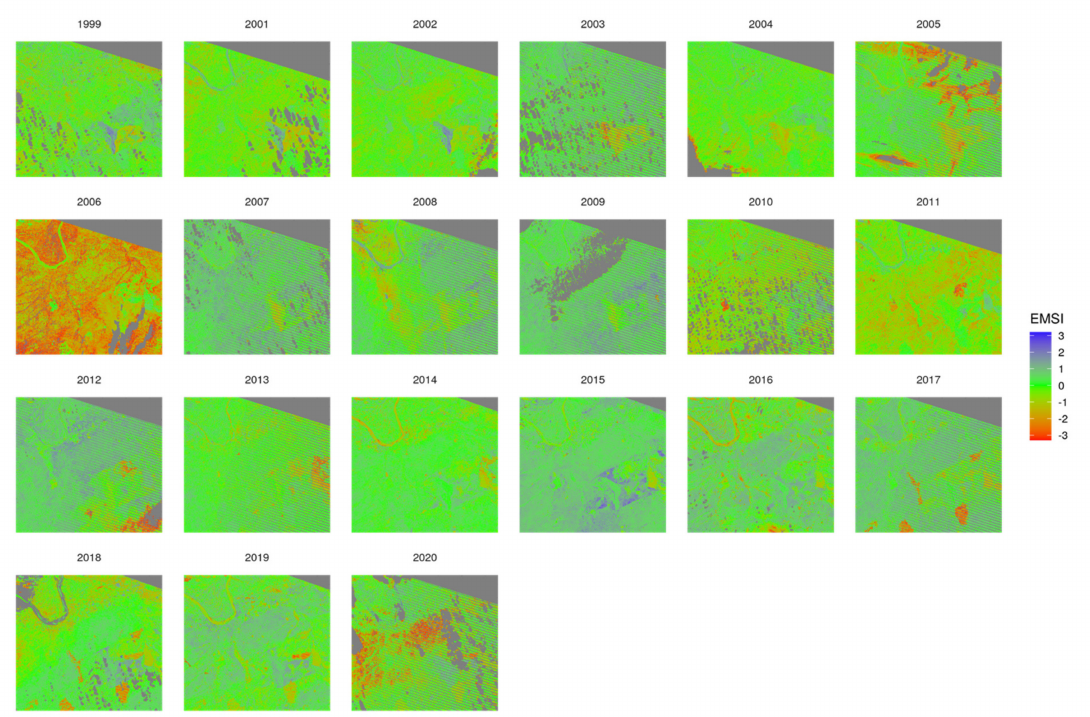
Figure A8. EMSI for 1999-2020 for Landsat 5, 7, and 8 time series for July in Yakutia, Russian Federation. The year 2000 had no clear sky scene. The two years with blue highlighted boxes are shown below in more detail in Figure 11. Pixels with no data due to masking are gray. Multiple repeated wildfires burn across the time series. In the EMSI trained on a global reference period (1999-2020) the areas which burn later in the scene are exceptionally high EMSI before the fire, and then disturbed